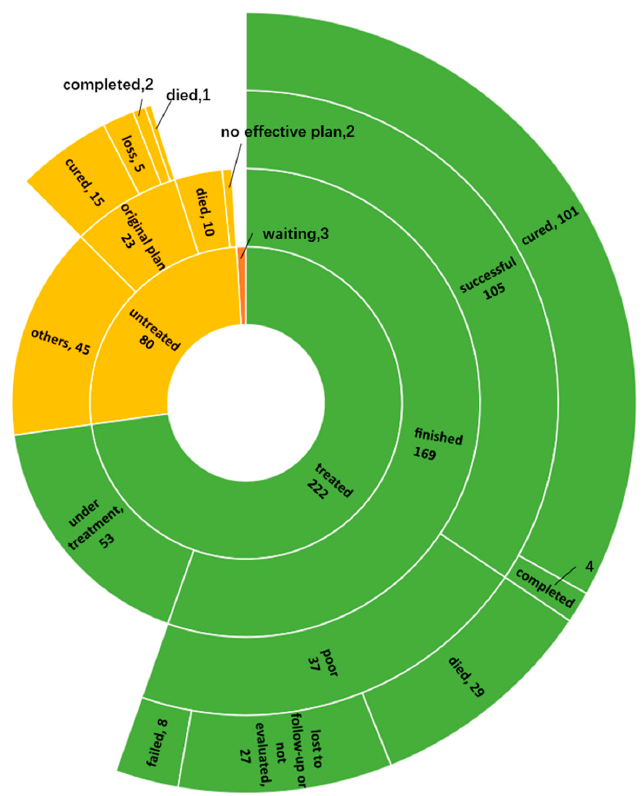
Figure 4. Outcome of 305 MDR/RR-TB patients.